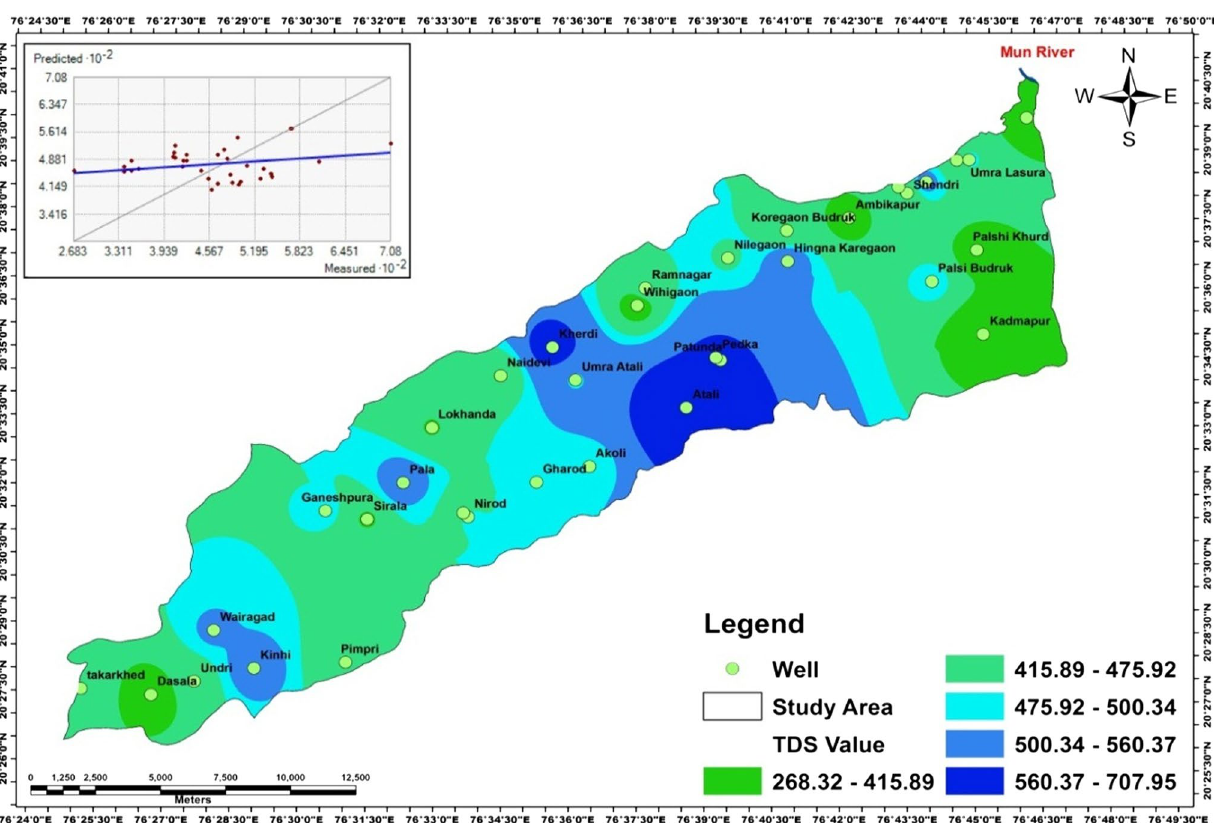
Fig. 6 Spatial distribution map of TDS post